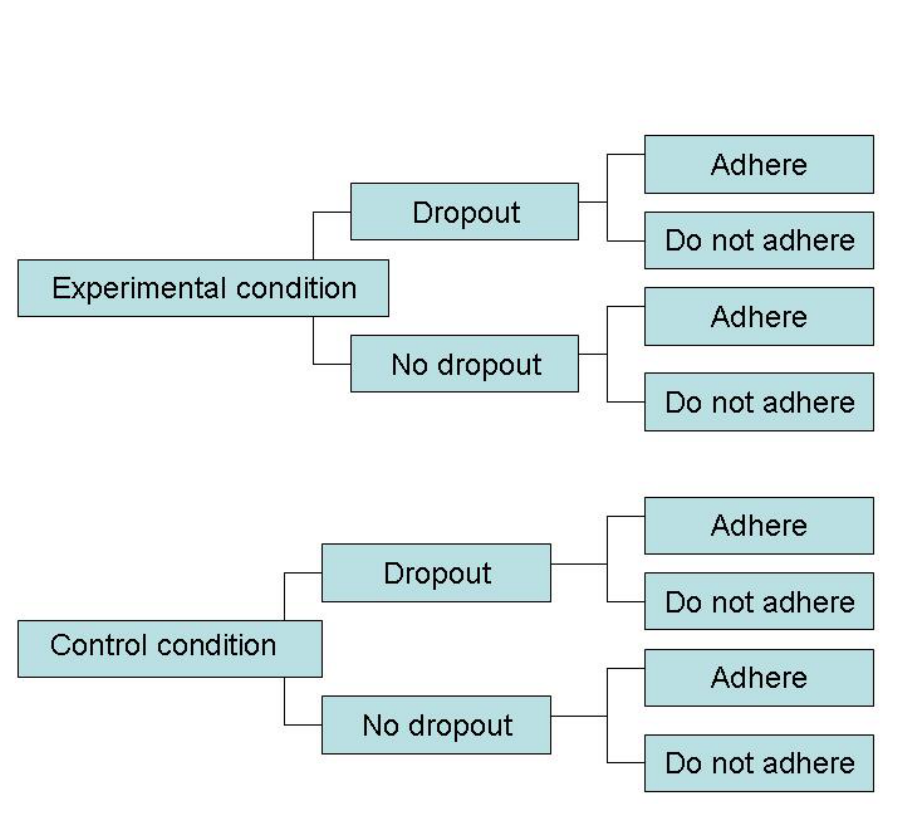
Figure 1. The relationship between dropout and adherencein a two-arm trial